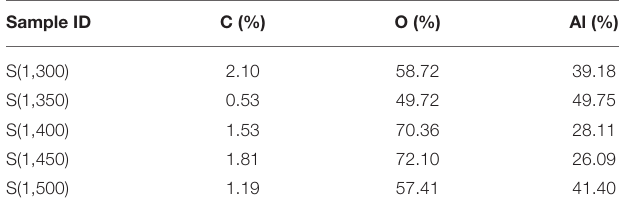
TABLE 3 | Atomic fraction obtained from